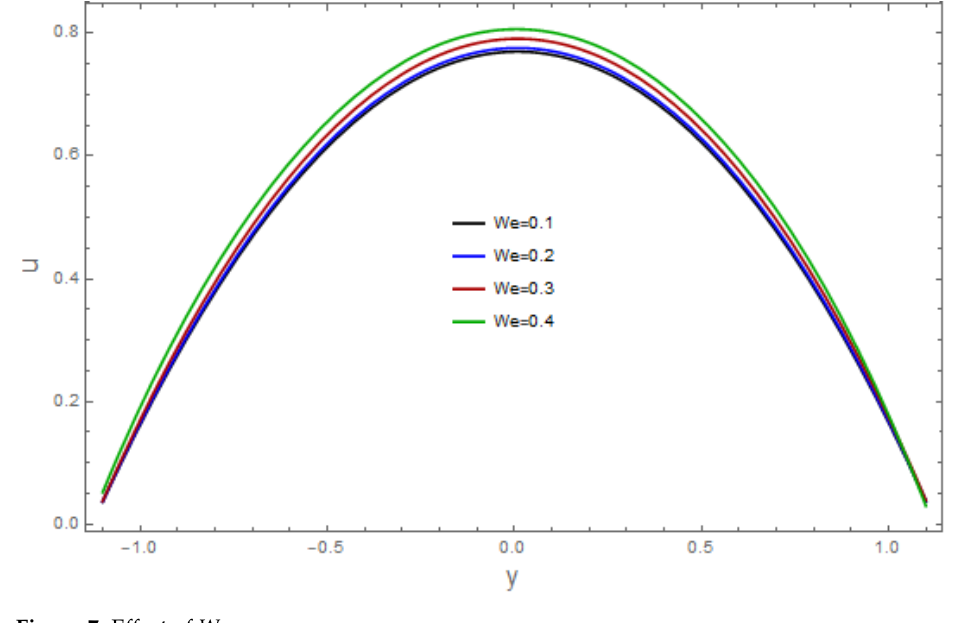
Figure 7. Effect of 𝑊𝑒 on 𝑢 .